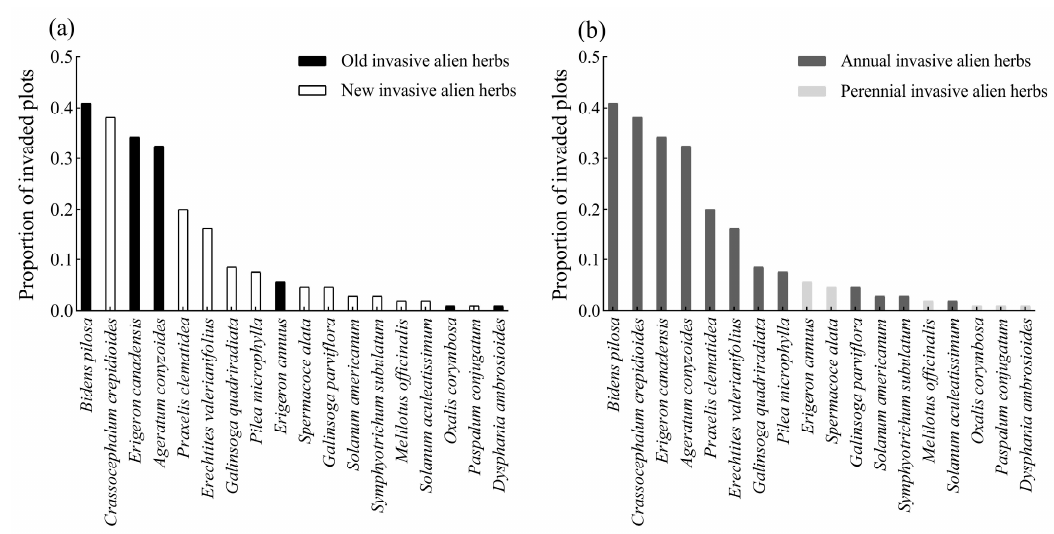
Figure 2. Occurrence frequency rates of ( a ) new and old invasive alien herbs and ( b ) annual and perennial invasive alien herbs in Dayao Mountain Reserve. The y-axis indicates the proportion of samples in which each species was present. Black, white, dark gray, and light gray represent old, new, annual, and perennial invasive alien herbs, respectively.